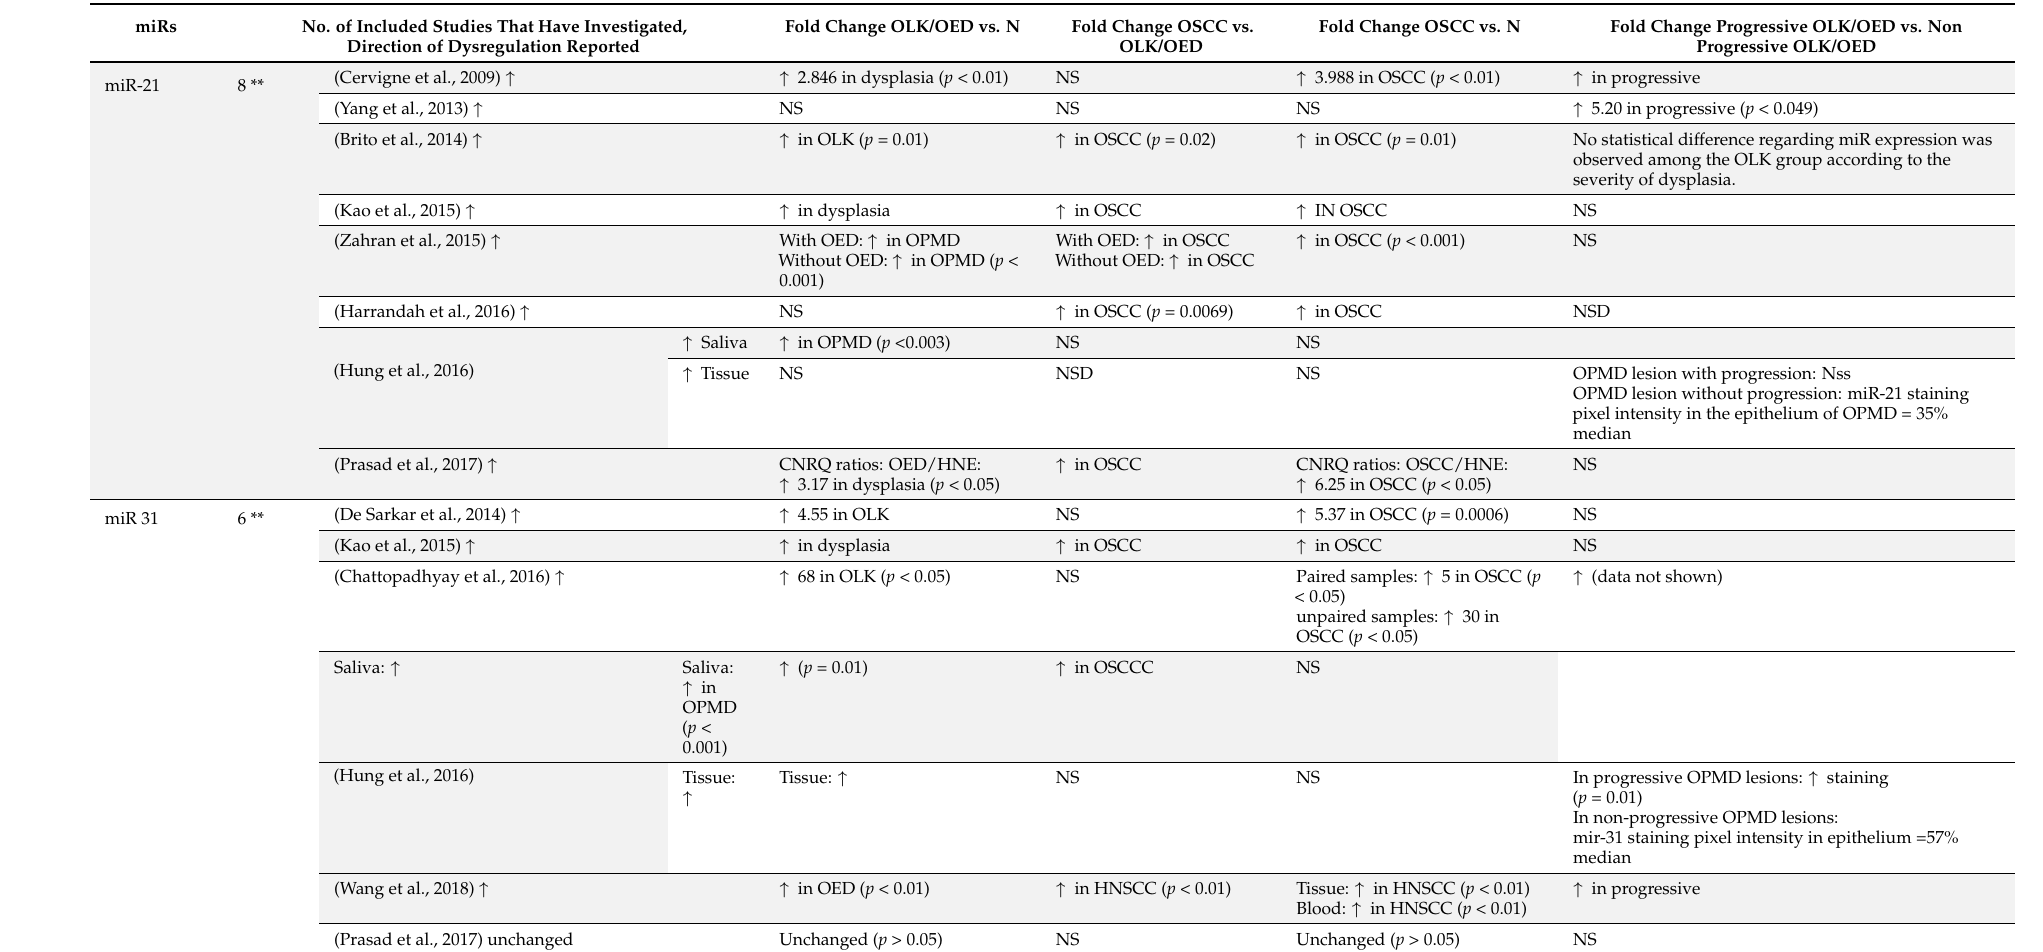
Table 4. Most-investigated miRNAs in relation to OLK/OED and OSCC and key